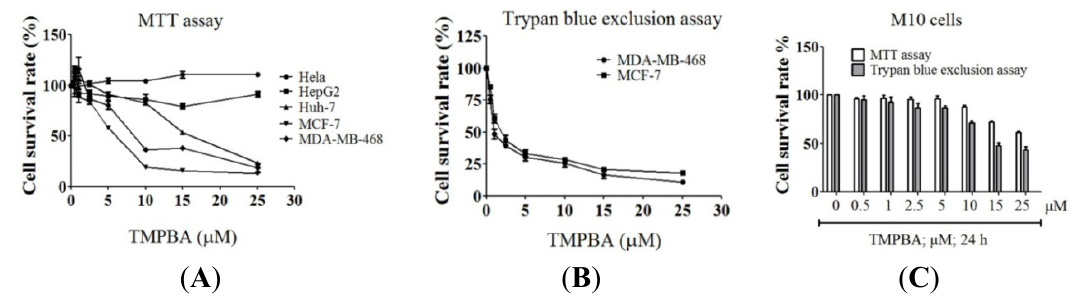
Figure 2. The anti-proliferative activity of TMPBA in Hela, HepG2, Huh-7, MCF-7 and MDA468 cells. ( A ) The effect of TMPBA on the cell viability of different cancer cell lines was assessed by MTT assay after treatment for 24 h. Points, mean; bars, SD ( n = 6); ( B ) The effects of TMPBA on MCF-7 and MDA-MB-468 cells were assessed by trypan blue exclusion assay after treatment for 24 h. Points, mean; bars, SD ( n = 6); ( C ) The effects of TMPBA on the cell viability of M10 cell line was assessed by MTT assay and trypan blue exclusion assay after treatment for 24 h. Points, mean; bars, SD ( n = 6).